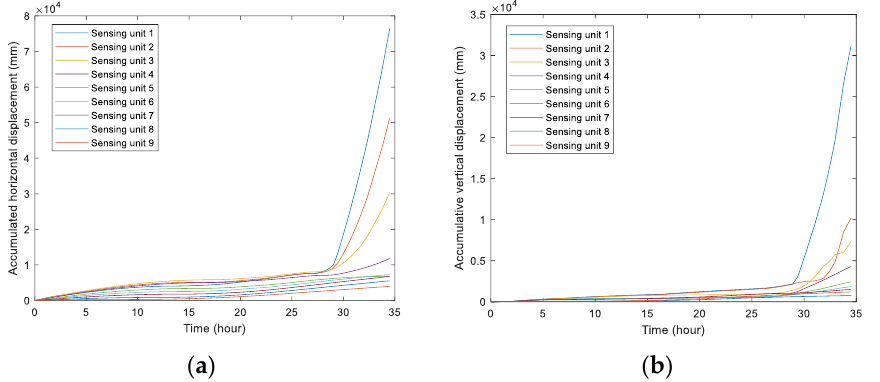
Figure 11. Curve of actual depth deformation.